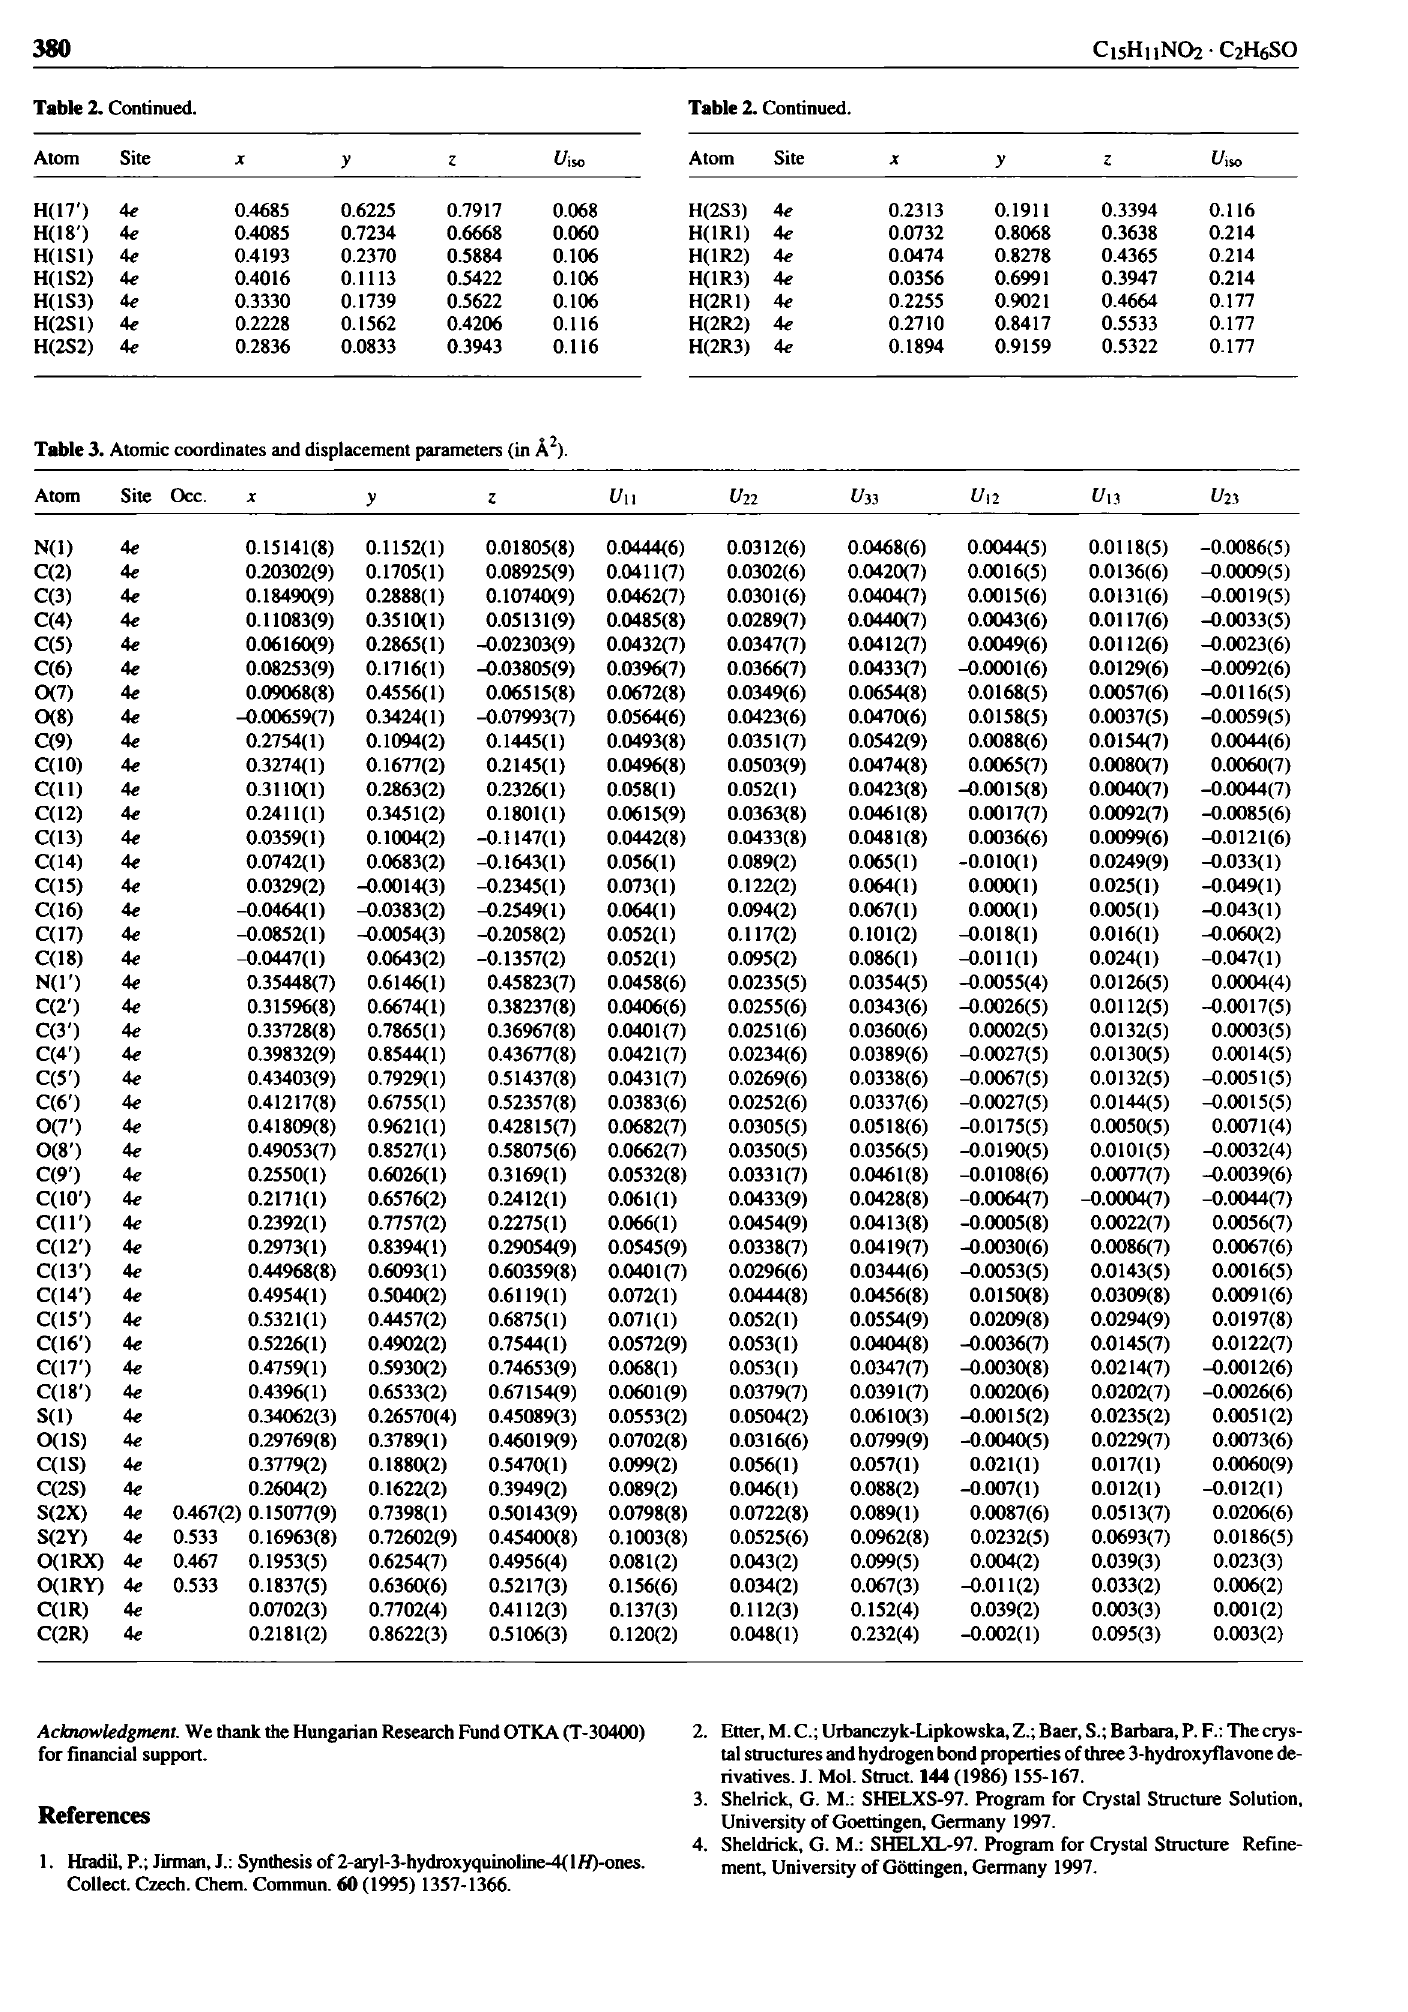
Table 3. Atomic coordinates and displacement parameters (in Â 2